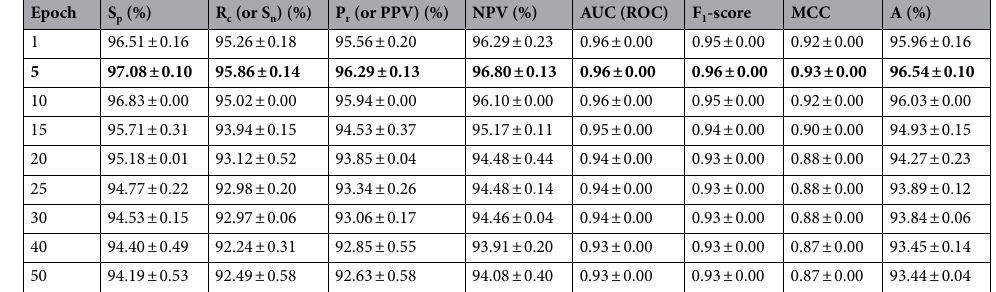
Table 6. Proposed system results (tenfold-cross validated) with epochs variation depicting analysis based on performance using k -NN classifier with k = 1 for BraTS-2021 dataset (with RA). Significant values are given in